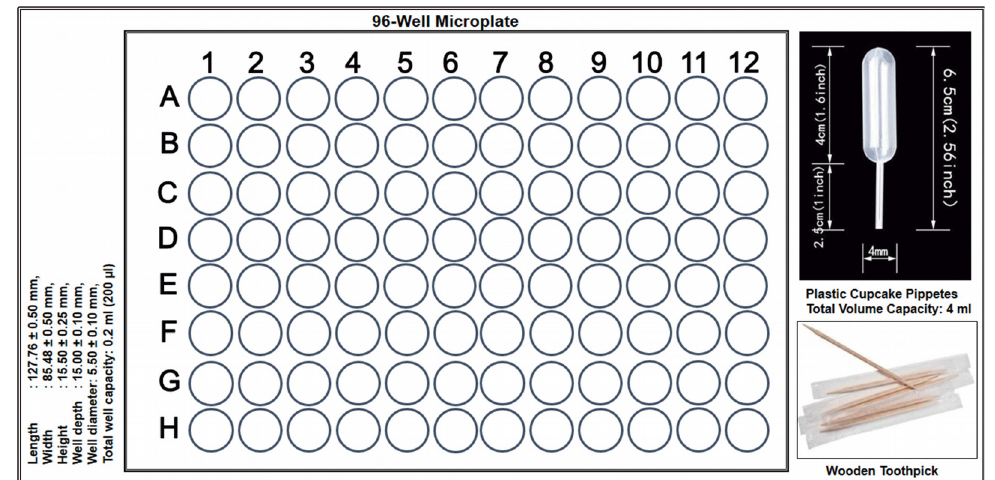
Figure 2. The main tools used for practicum with a small-scale chemistry